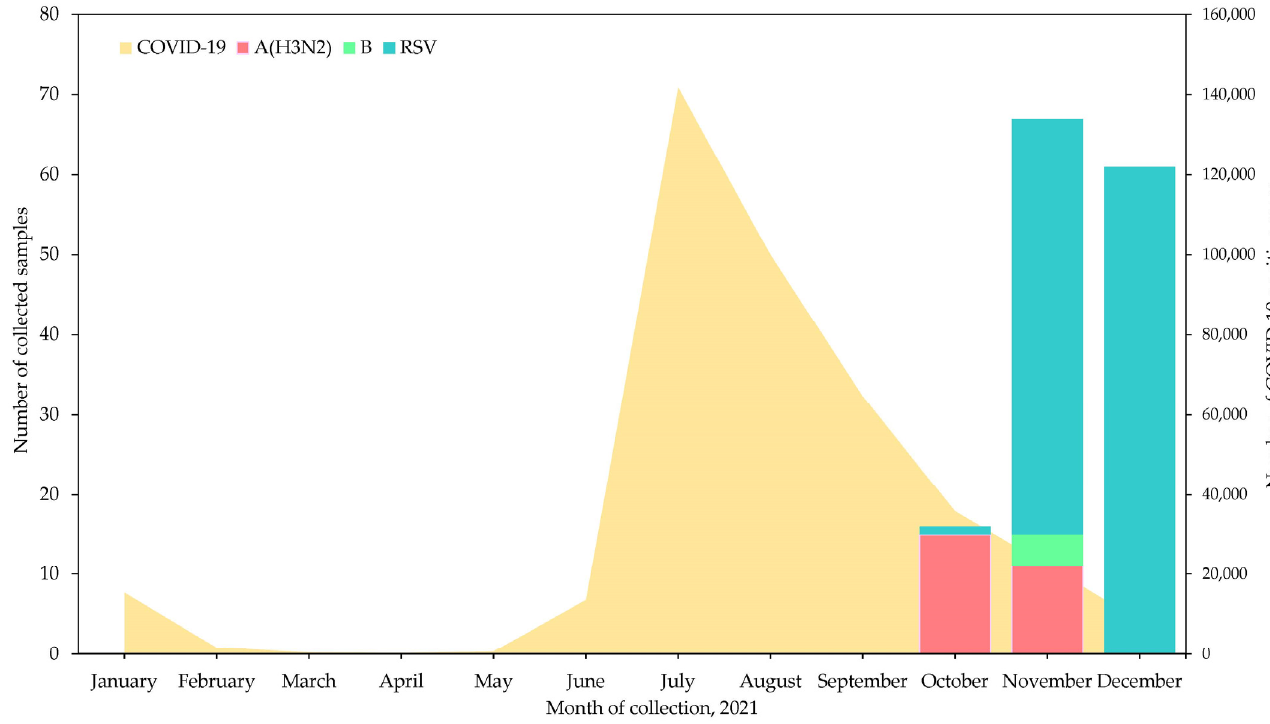
Figure 1. Epidemic curve of influenza A(H3N2), B and respiratory syncytial virus (RSV) confirmed with BioFire ® FilmArray ® RT-PCR in this study and the official number of COVID-19 cases from the Myanmar COVID-19 surveillance dashboard of the Myanmar Ministry of Health in Yangon, 2021 (https://mohs.gov.mm/Main/content/new/list?pagenumber=1&pagesize=9, (accessed on 16 December